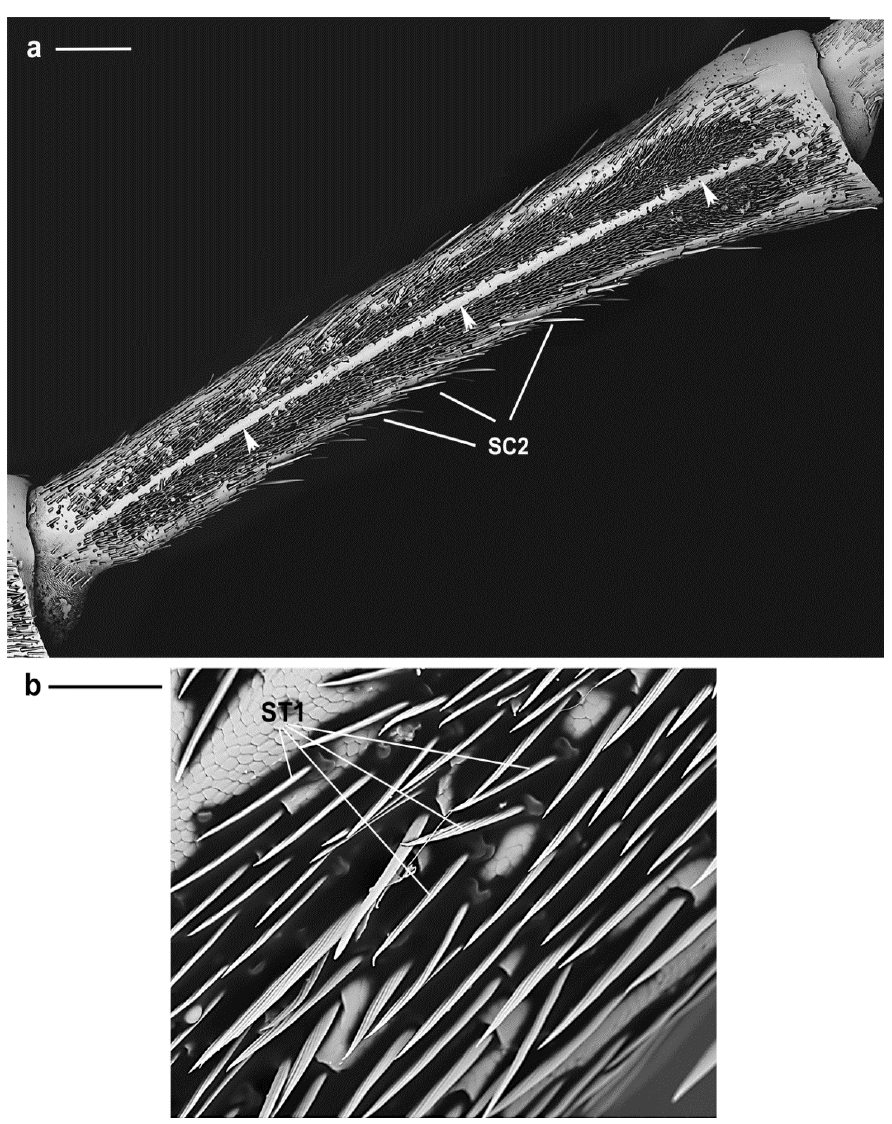
Figure 9. A. bungii male, SEM. ( a ) Overview of the second flagellomere with the two longitudinal bands facing the abaxial surface and separated by a longitudinal strip devoid of any sensilla (arrowheads). Such bands are packed with SC1, SC2, SB and ST1. ( b ) Detail of ST1 showing a thin straight shaft projecting from a raised base with no evident articulation. Abbreviations: SC2, sensillum chaeticum type 2; ST1, sensillum trichodeum type 1. Scale bars: 500 µm ( a ); and 100 µm ( b ).